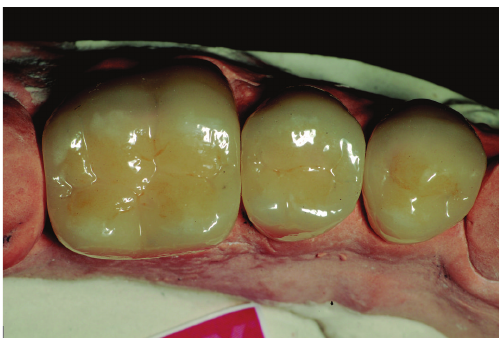
Figure 9: Laboratorial aspect of the posterior all-ceramic crowns.